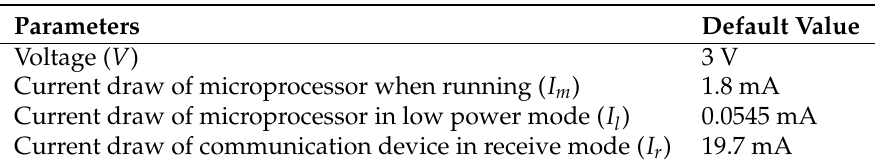
Table 4. Energy consumption parameters